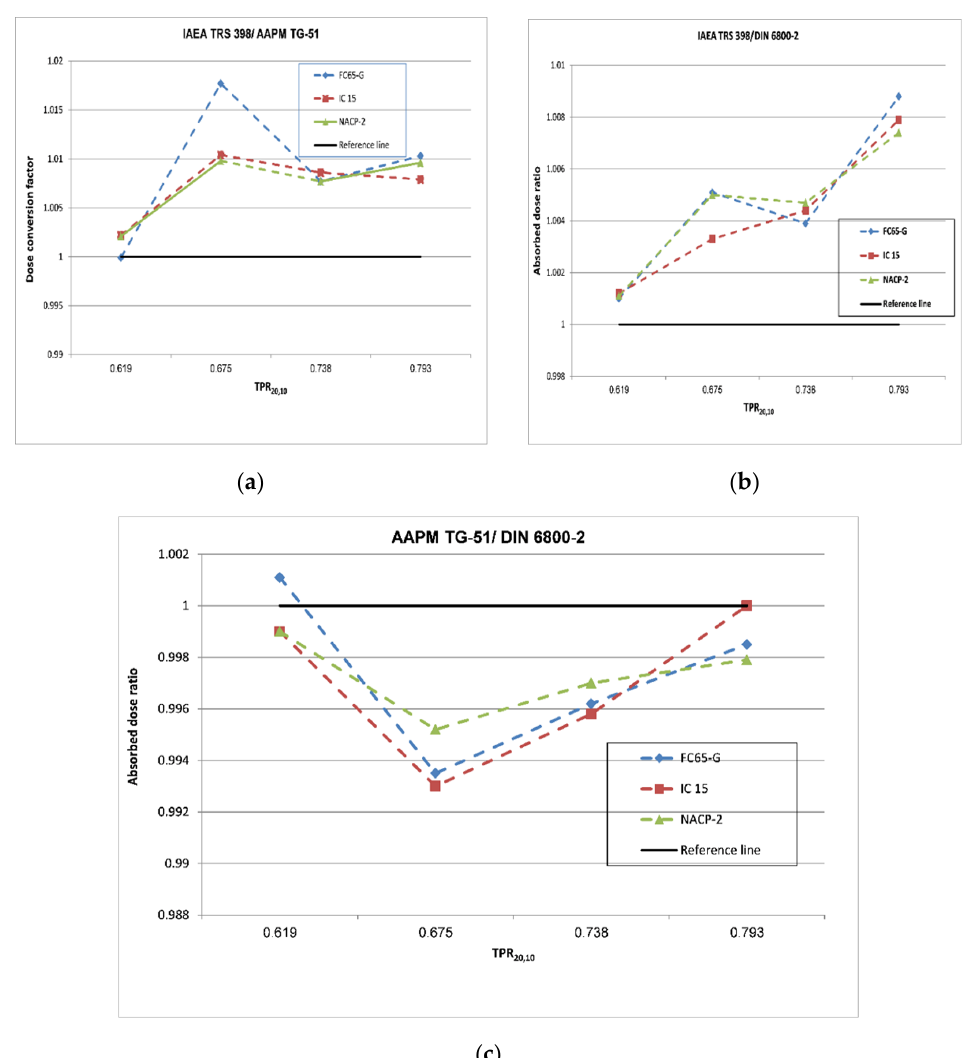
Figure 2. The absorbed dose to water ratios obtained with three ionization chambers: ( a ) AAPM TG-51/IAEA TRS-398, ( b ) IAEA TRS-398/DIN 6800-2, and ( c ) AAPM TG-51/DIN 6800-2. The cylindrical chambers demonstrated a chamber-to-chamber dose variation of